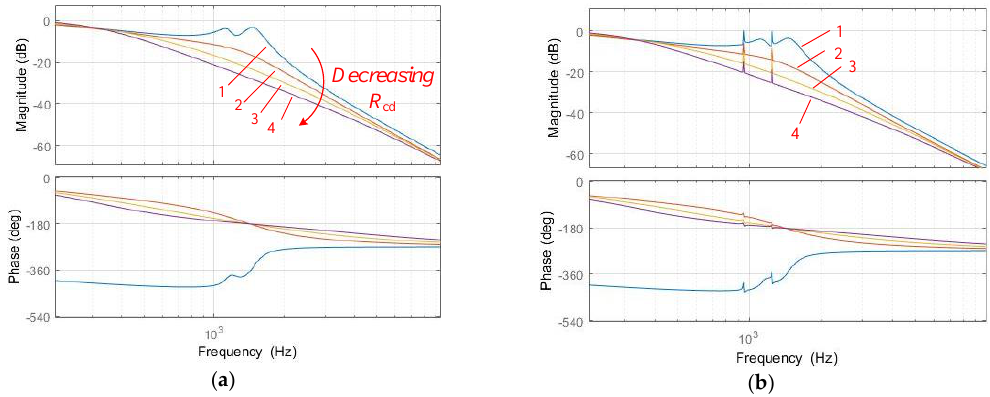
Figure 9. Bode diagram of 3-parallel HCGIs with different R cd : ( a ) Without high-frequency harmonics compensation; ( b ) With high-frequency harmonics compensation.